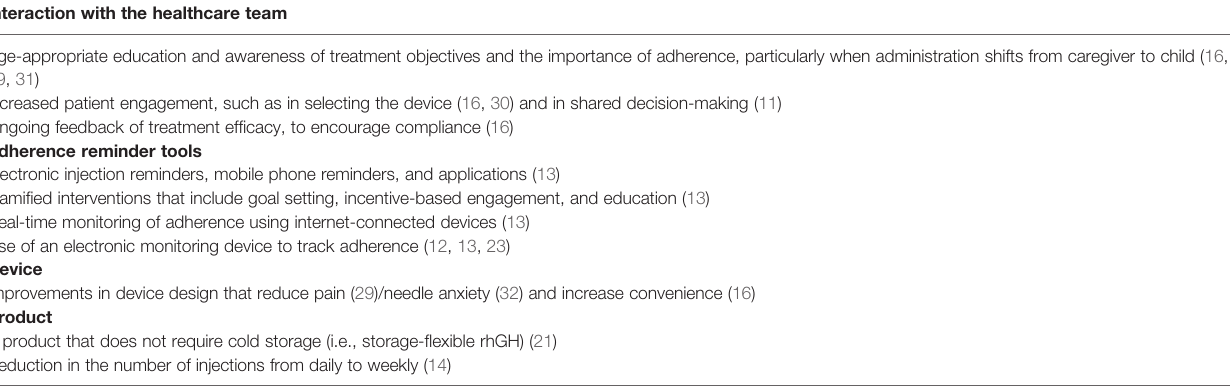
TABLE 2 | Recommendations for improving